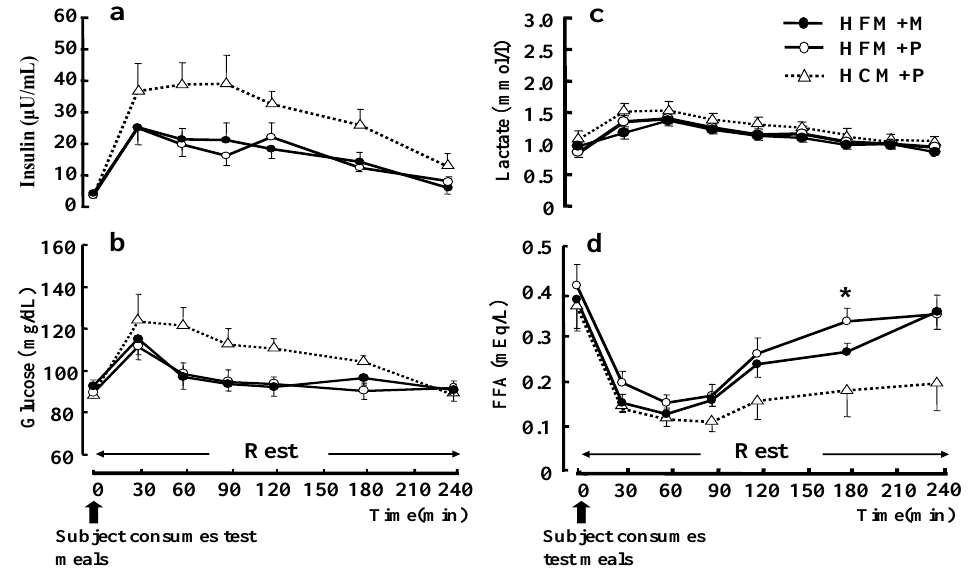
Figure 6. Changes in insulin ( a ), glucose ( b ), lactate ( c ), and free fatty acids (FFA) ( d ) at rest. Data were analyzed using a two-way analysis of variance (ANOVA) with repeated measures. Tukey’s test was used to identify any statistically significant differences. * indicates when high-fat meal with placebo (HFM + P) values were significantly higher than high-carbohydrate meal with placebo (HCM + P) values ( p < 0.05). (HFM + M: high-fat meal with maltodextrin). Data are shown as mean ±